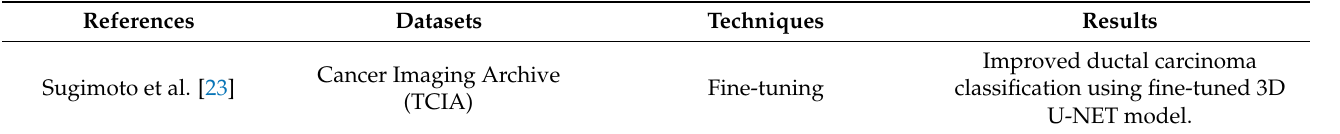
Table 1. Comparative analysis of 3D-U-Net-model-related